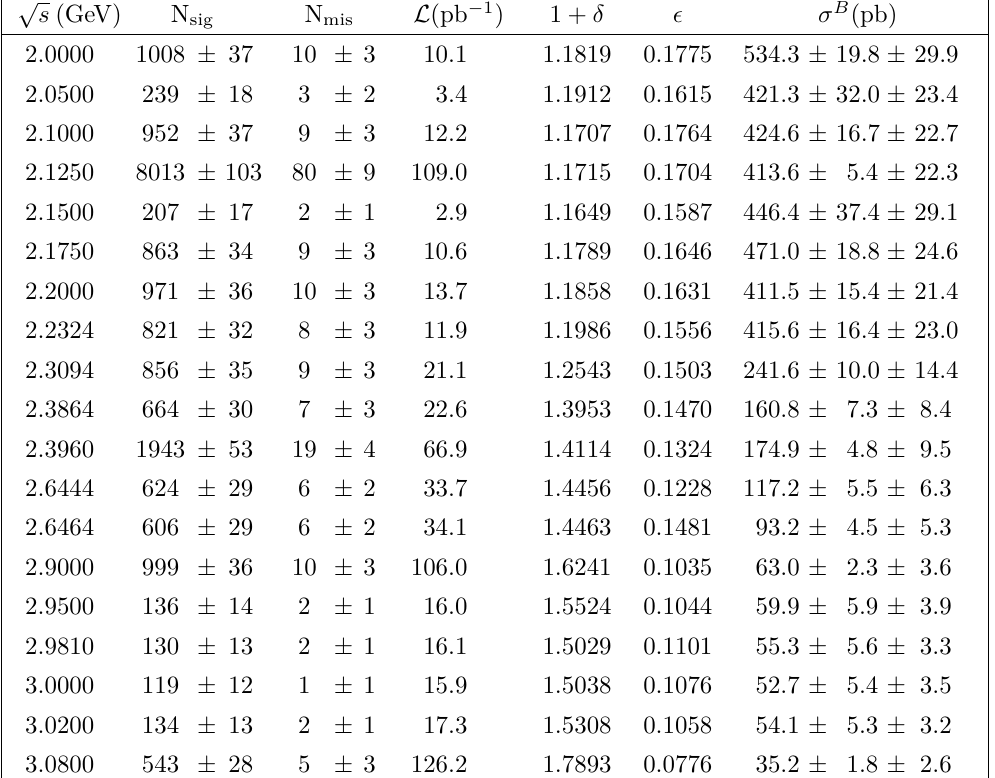
Table 4 . Summary of the signal yield ( N sig ), number of mis-combination events ( N mis ), integrated luminosity L , ISR correction factor ( 1 + δ ), detection efficiency ( (cid:15) ), and total Born cross section of e + e − → ωπ + π − ( σ B ) at various energy points statistical. The first and second uncertainties of Born cross sections are statistical and systematic,